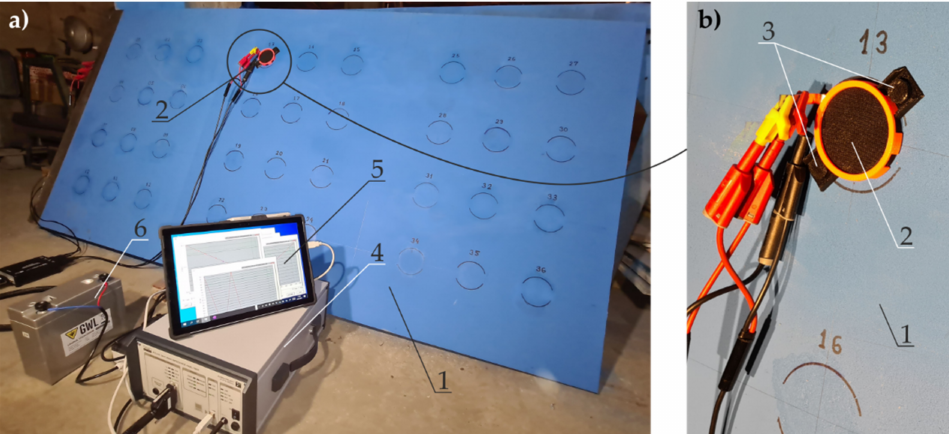
Figure 7. A stand for the EIS testing with a probe filled with gel electrolyte: ( a ) steel sheet with paint coating, the instrument, and the measuring head; ( b ) the measuring head. 1—test sheet of 2000 × 1000 mm surface area with blue coating; 2—measuring head; 3—neodymium magnets of the head; 4—high impedance analyser; 5—hybrid laptop;